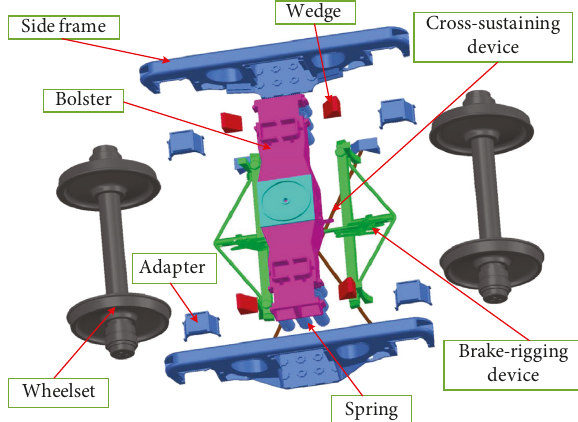
Figure 2: Structure diagram of K6-type